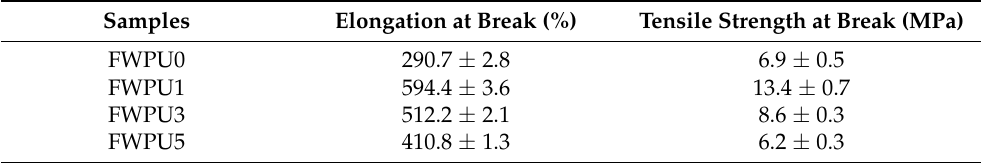
Table 2. The elongation at break and the tensile stress of different films.